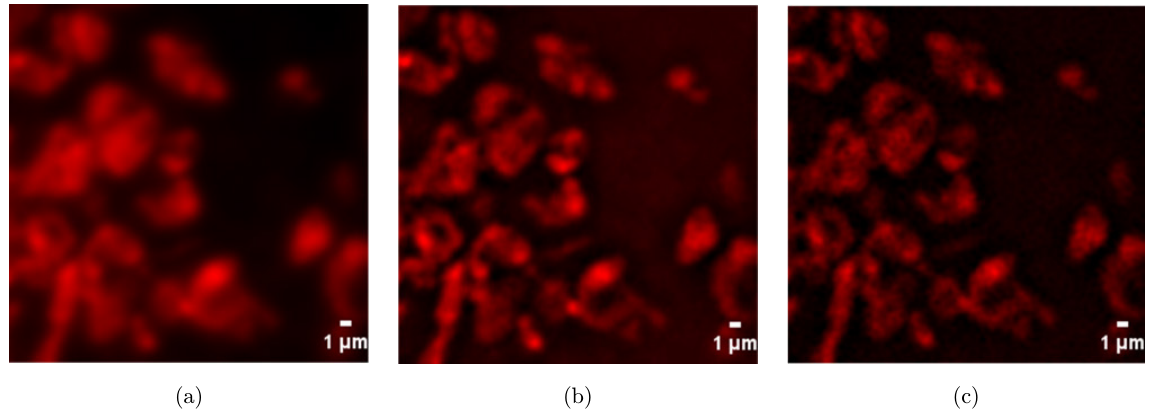
Fig. 7. Comparison of the reconstructed images under di®erent duty cycles. (a) wide ¯eld image; (b) image reconstructed under